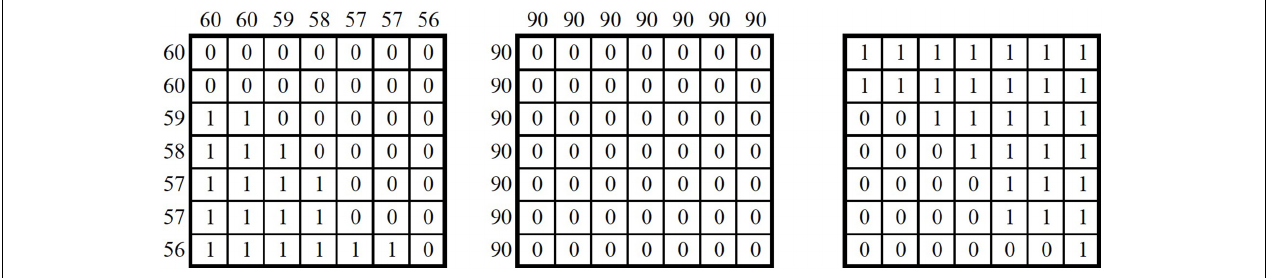
FIGURE 2 | Contour matrices for the pitch of Task 1–Phrase 7 with male speech demonstration (left) , ò.jà interpretation (middle) , and similarity matrix (right) . TABLE 1 | Results for Task 1 (speech to music).